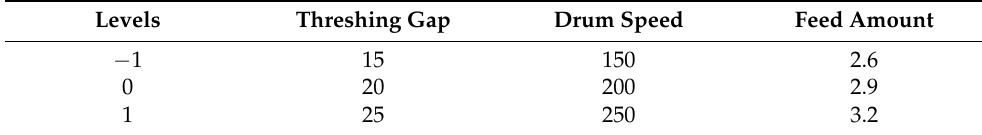
Table 2. Coding table of the test factor